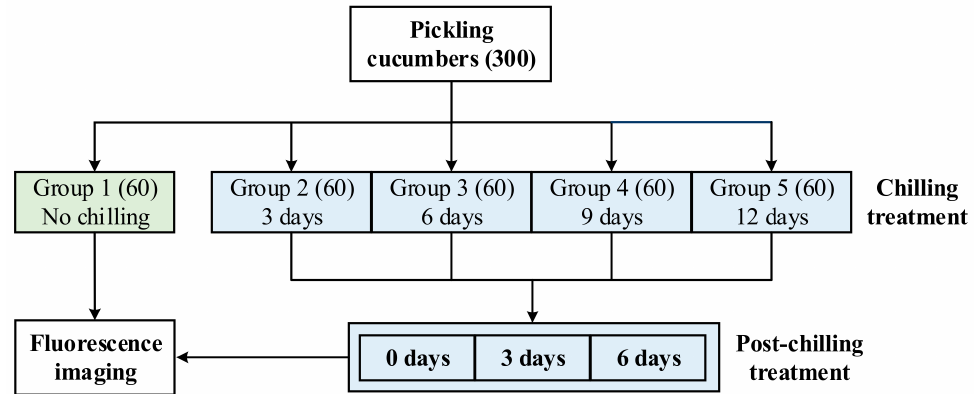
Figure 1. The groups of pickling cucumbers subjected to different treatments. The chilling and post-chilling (i.e., removing samples from cold storage to room temperature) treatments for different days are to induce varying degrees of chilling injury damage.